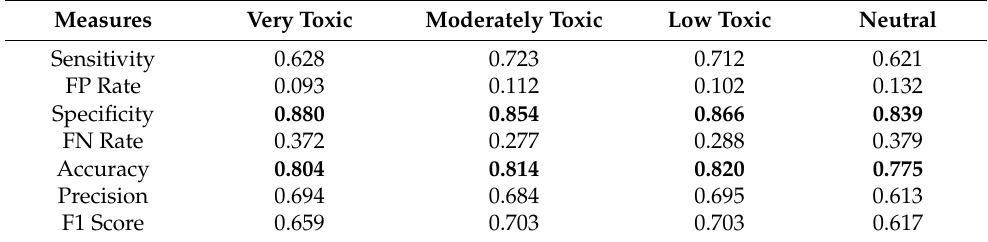
Table 6. Effectivity of SVM1 model for recognition of four degrees of toxicity in online